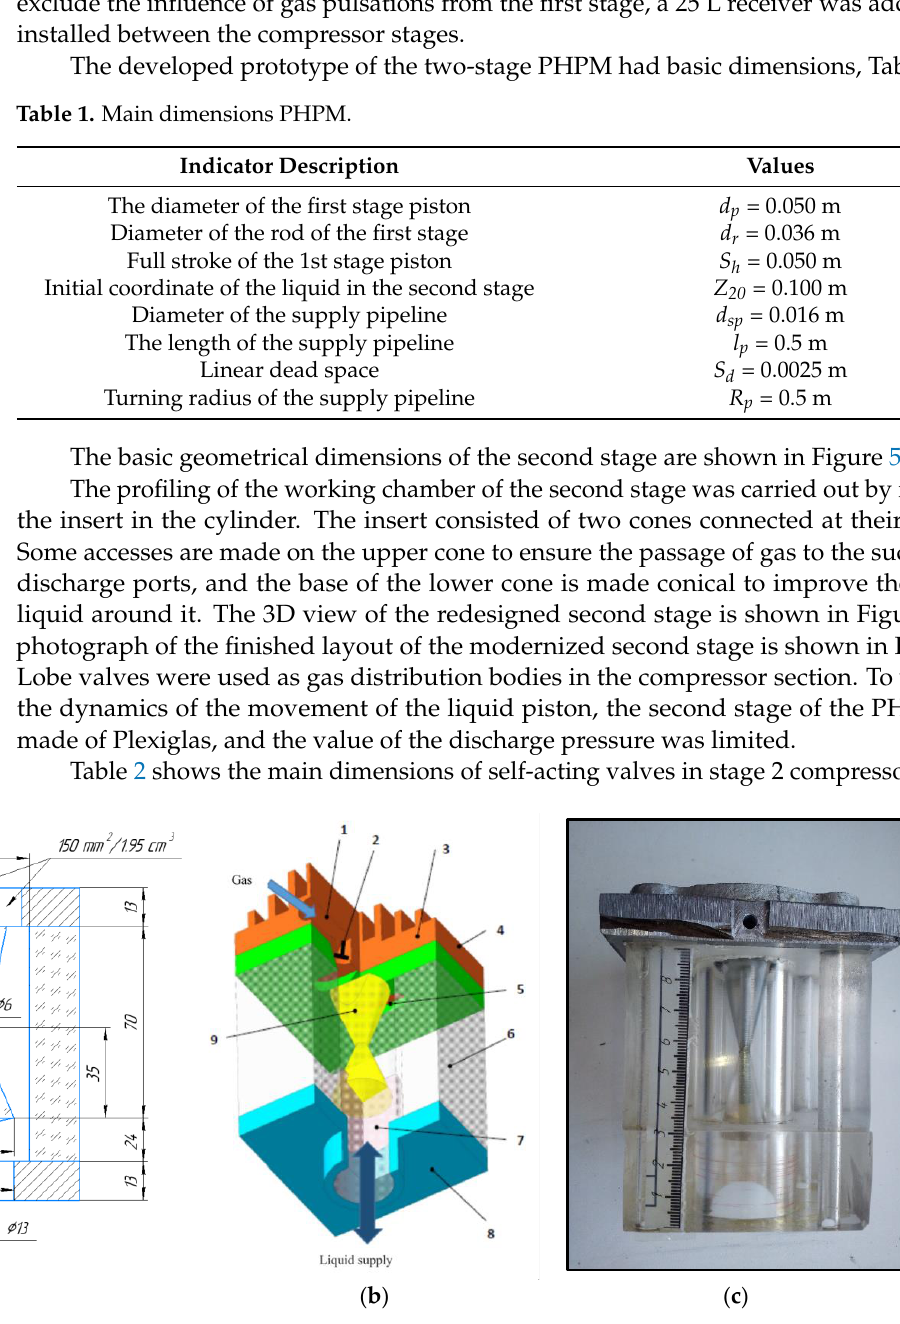
Figure 5. The profiling of the working chamber of the second stage: ( a ) Section of the working chamber of PHPM stage 2 with indication of the main size dimensions; ( b ) 3D image of the layout of the prototype of PHPM stage 2 (1. Suction line. 2. The suction valve of stage 2 of the compressor (shown conventionally). 3. Valve body. 4. Top flange. 5. Discharge window. 6. Plexiglas cylinder. 7. Liquid piston. 8. Bottom flange with tube. 9. Profiled insert); ( c ) Image of the PHPM stage 2 prototype.